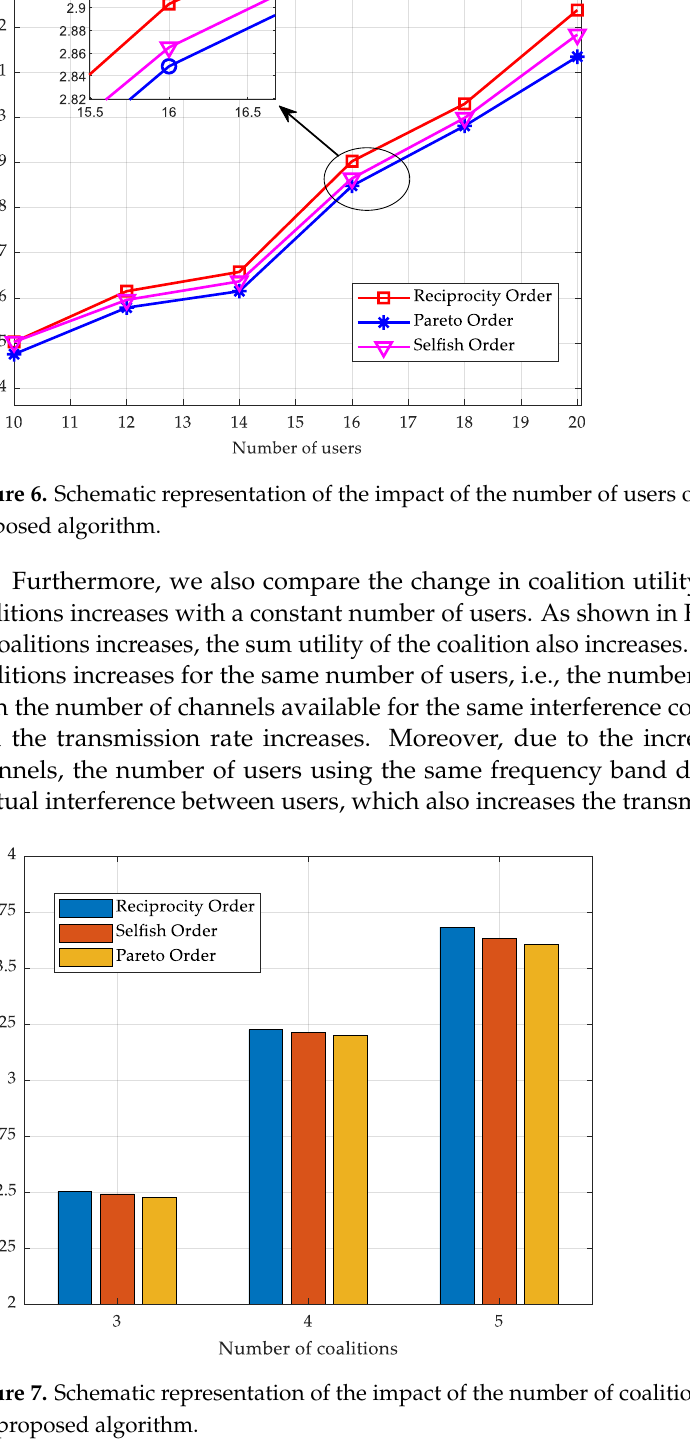
Figure 5. Schematic representation of the effect of interference power on the proposed algorithm.